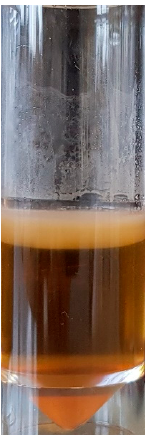
Figure 2. A bacterial cellulose “biofilm” being formed on the surface of a liquid medium.